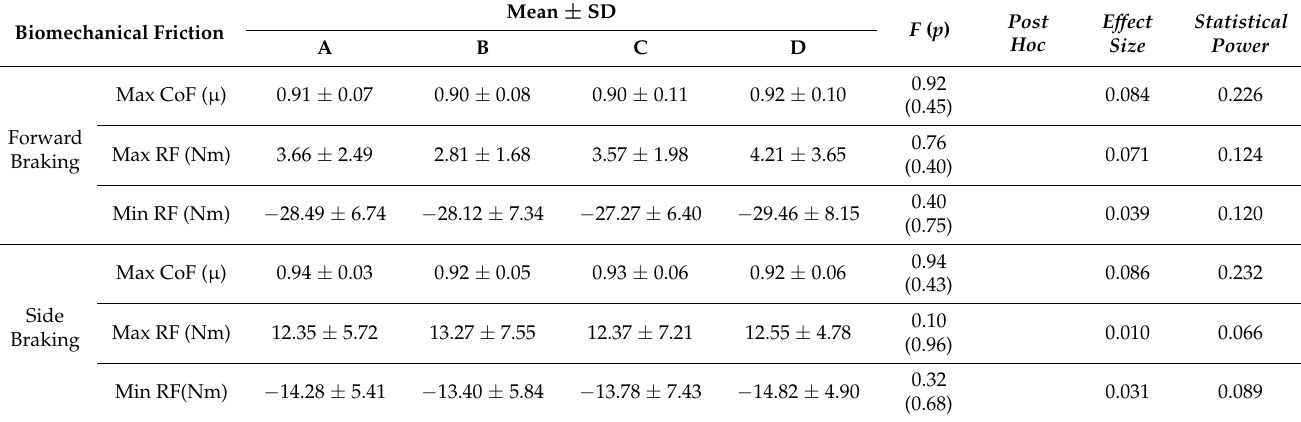
Table 2. Frictional force depending on outsole pattern upon motion in a biomechanical